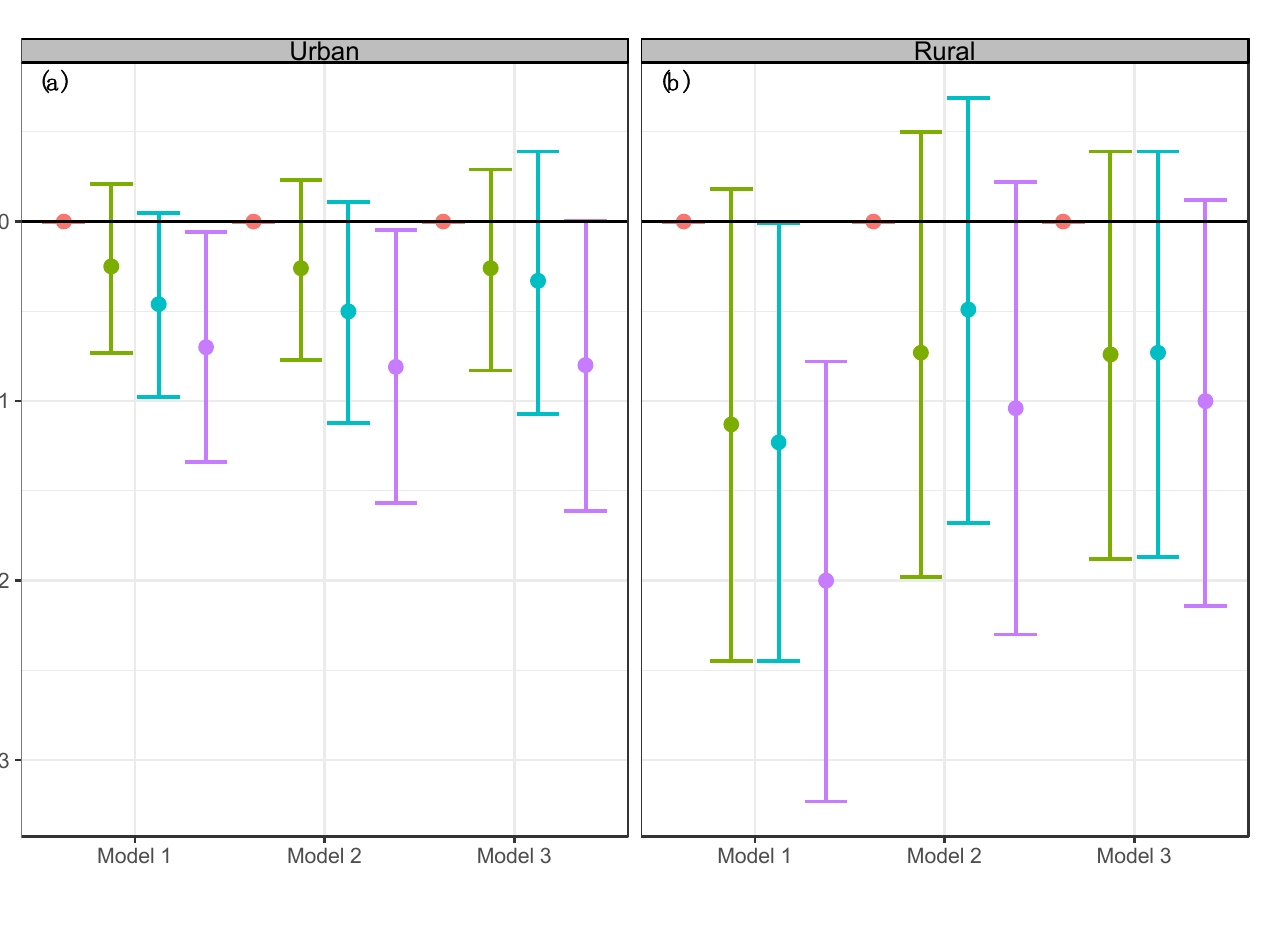
Figure 4. Linear models stratified by area for BMI in the Mexican adult population by the difference quartiles of NDVI. ( a ) Urban area ( b ) Rural area. Model 1 = Linear regression model for BMI and NDVI stratified by urban and rural areas. Model 2 = Adjusted linear regression model for BMI, NDVI, age, sex, region, socioeconomic status, and education level stratified by urban and rural areas. Model 3 = Adjusted linear regression model for BMI, NDVI, physical activity, age, sex, region, socioeconomic status, and education level stratified by urban and rural areas.